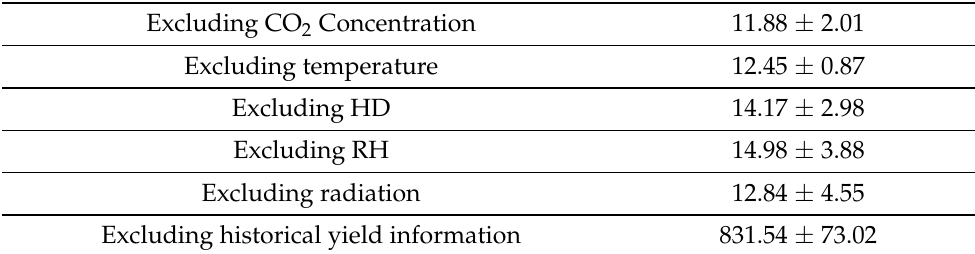
Table 5. Statistical metrics (mean and standard deviation) of RMSEs (g/m 2 ) by excluding certain input factors.